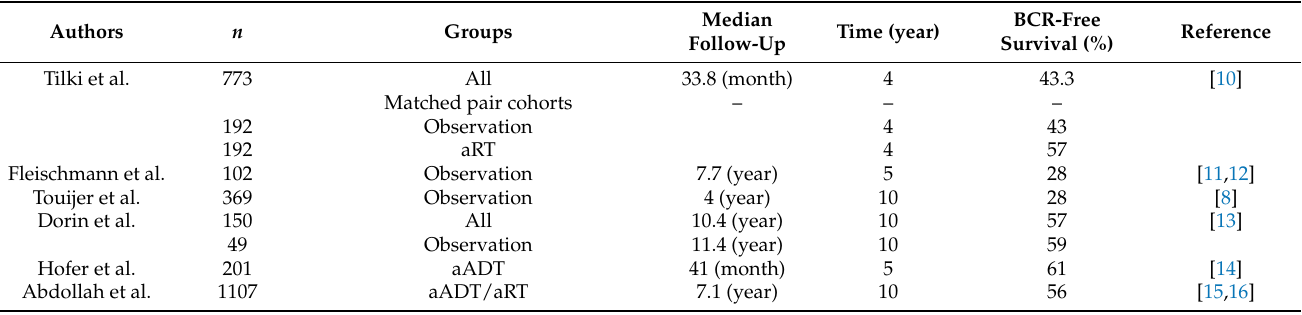
Table 1. Prognosis among men with